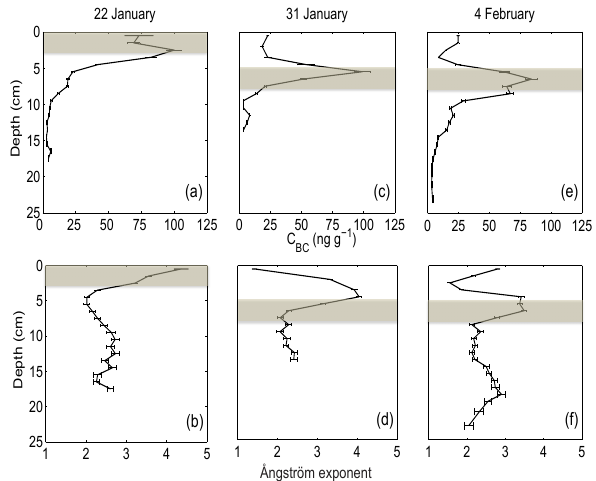
Figure 2. Snow optical properties measured on 22 January (left), 31 January (middle), and 4 February (right). (top) Vertical profiles of mean snow black carbon ( C BC , ngg − 1 ) measurements and the full range of C BC measured at each depth (horizontal black lines), (bottom) mean Ångström exponent ( Å , unitless) measurements and the full range of Å measured at each depth (horizontal black lines). The brown shaded region represents the dusty layer as defined in the text.